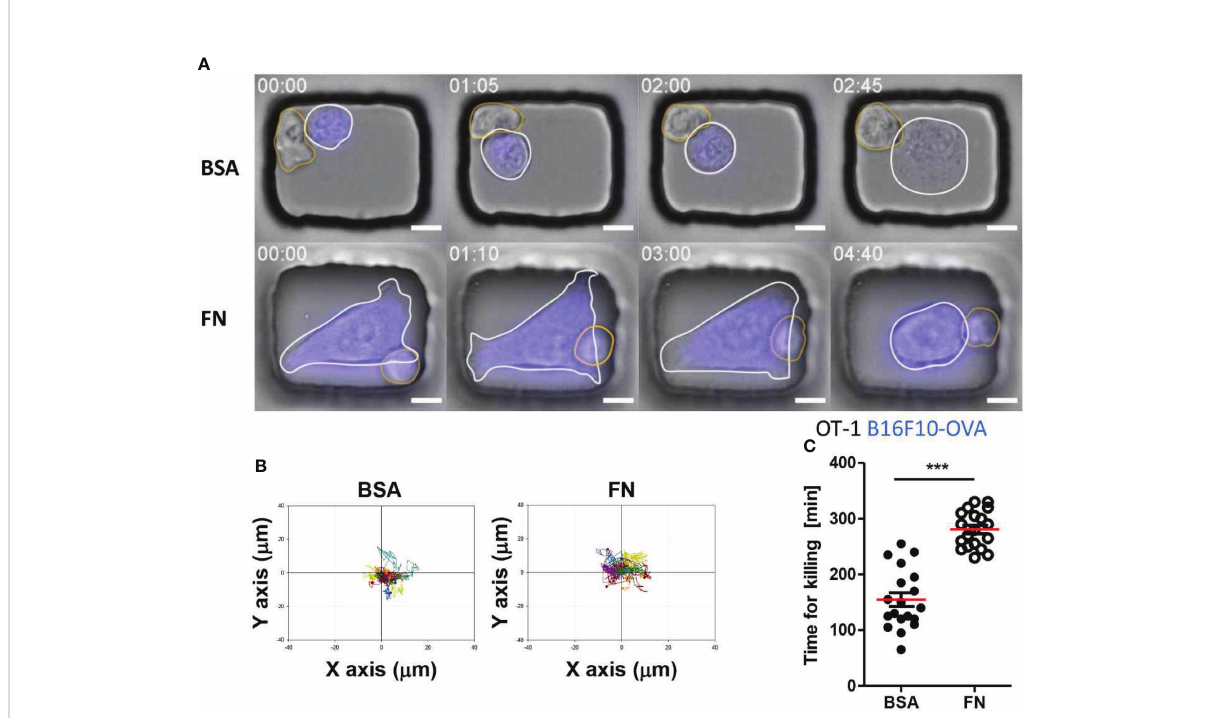
FIGURE 6 Dynamic behaviors and cytotoxicity of T cells in microwells coated with BSA or FN. (A) Representative time-lapse images of OT-1-B16F10-OVA interactions in microwells coated with BSA or FN. Scale bars: 10 m m. (B) Representative trajectories of T cell centroid. For each case, 15 T cells were traced over 5 h and plotted with the initial T-tumor contact points as the origin. (C) Effects of microwell surface coating on time for killing. Mann-Whitney test was used, *** <